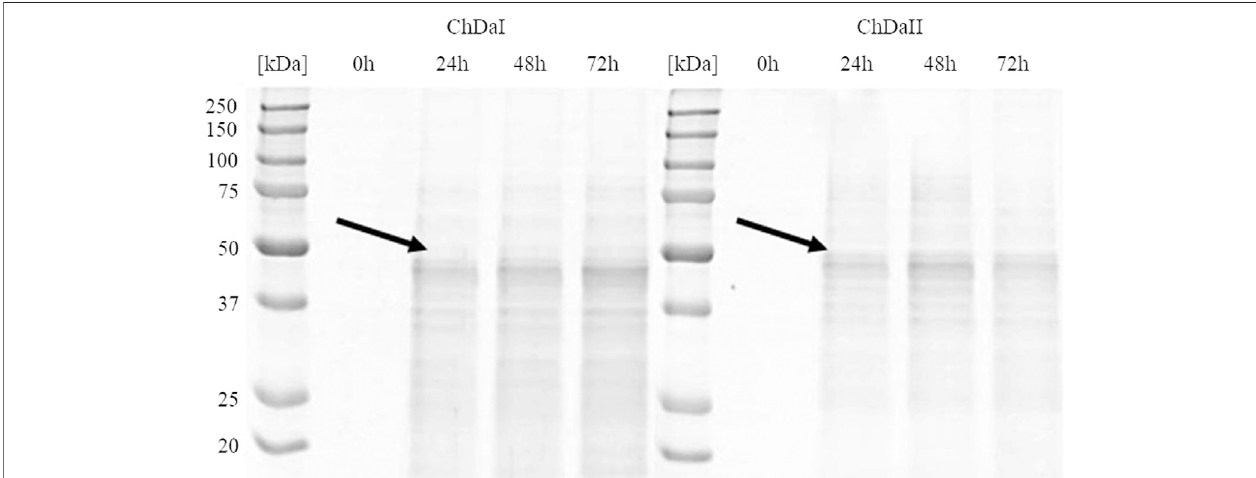
FIGURE3| Resultsofelectrophoreticanalysis(SDS-PAGE)ofproteinspresentintheculturemediumobtainedafter thecultivationofselectedtransformantsofthe KM71H_pPICZ_chdaI (ChDaI) strain and the KM71H_pPICZ_chdaII (ChDaII) strain. The two expressed proteins of the molecular weight of approximately 44 kDa are indicatedwitharrows.Thecultureliquidsanalysedwerecollectedatdifferentculturetimes:0,24,48and72 hfromthestartofmethanolinduction.PrecisionPlusProtein Unstained Standards (Bio-Rad, United States) was used as the protein size standard. 4% stacking gel; resolving gel 12%, voltage 150 V.